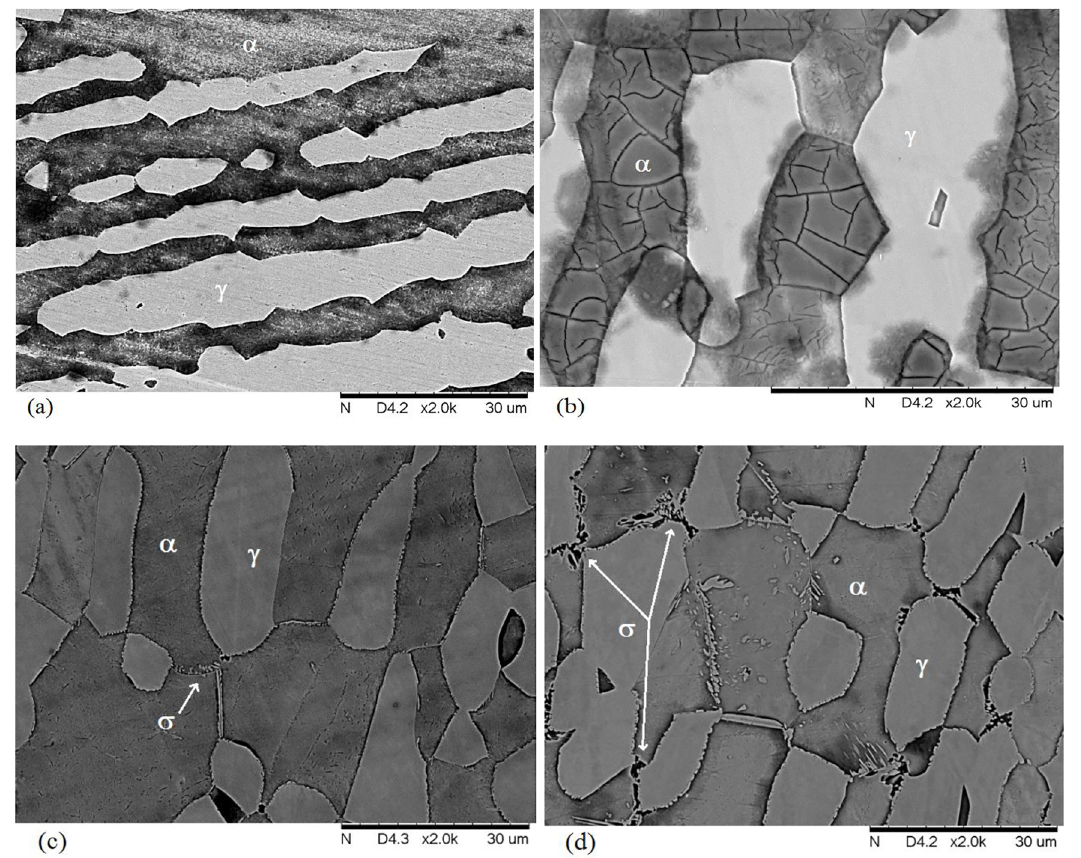
Figure 1. SEM of UNS S32520 super duplex stainless steel. (a) as-received; (b) solution-treated at 1150°C; (c) solution-treated at 1150°C and aged at 850ºC for 5 min., (d) solution-treated at 1150°C and aged at 850ºC for 10